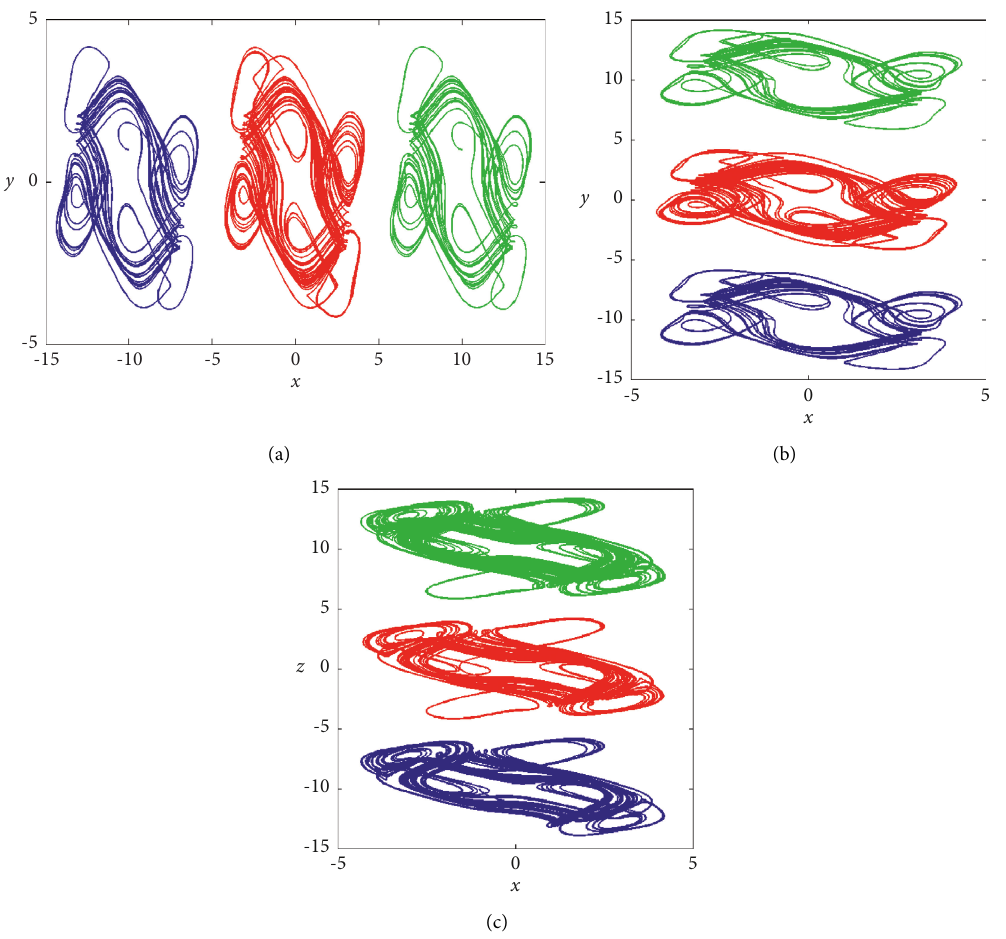
Figure 17: Scattering of the variable chaotic attractor on a 1D line for a � 1, b � − 9, and [ q m � ± 10 and m � 0, (b) y -line when n � ± 10 and n � 0, and (c) z -line when k � ± 10 and k �